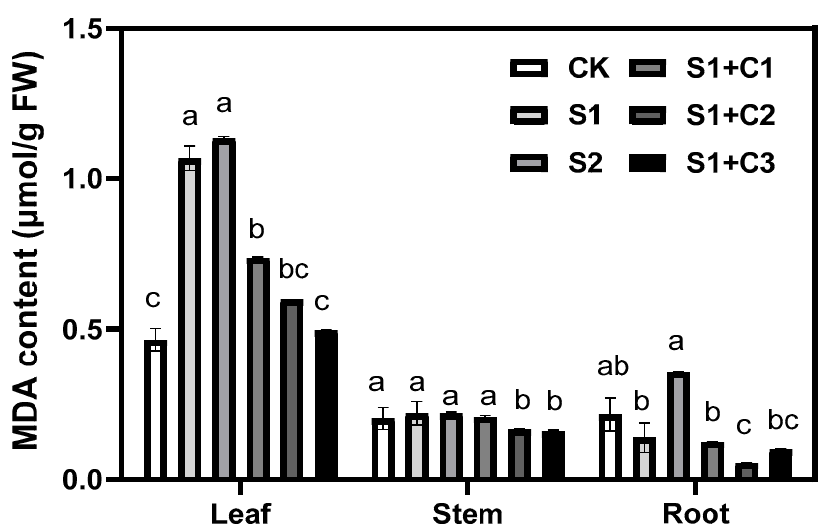
Figure 2. Effect of different salt concentrations and effect of different concentrations of exogenous calcium under salt stress on malondialdehyde content in G. sinensis seedlings. CK is a G. sinensis plant grown in normal hydroponic culture in Hogland nutrient solution. S1 and S2 are G. sinensis plants treated with concentrations of 100 and 200 mmol/L NaCl, respectively; S1 + C1, S1 + C2, and S1 + C3 represent 100 mmol/L NaCl with the addition of 5, 10, and 15 mmol/LCaCl 2 , respectively. After one week of all plant treatments, the malondialdehyde content was measured and analyzed using a UV spectrophotometer. The data are the average SD of three independent replicates. The mean values represented by the different letters were significantly different in Tukey’s test at p < 0.05.